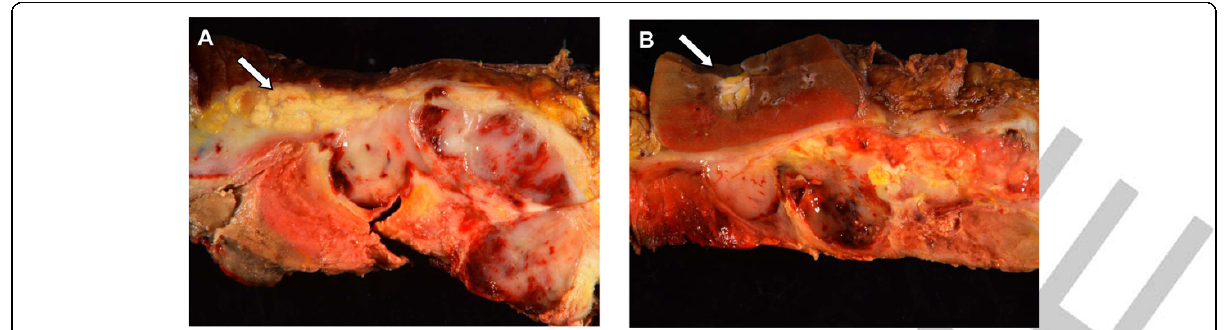
Figure 2 Adrenocortical carcinosarcoma gross appearance . A. Tumor adherent to pancreas (arrow) without apparent parenchymal involvement. B. Tumor compressing the adjacent left kidney (arrow) without parenchymal